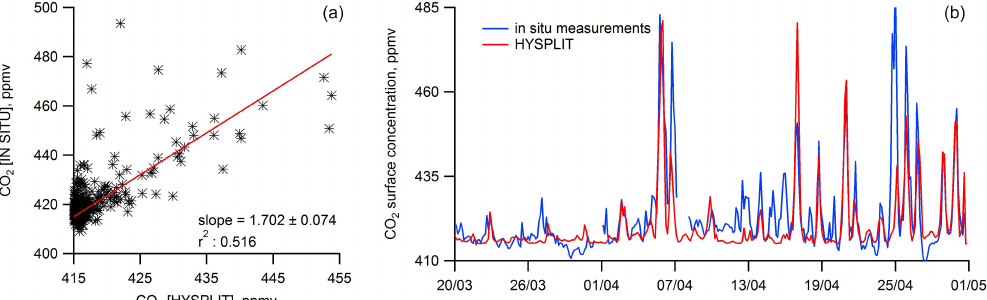
Figure 4. Comparison of the HYSPLIT simulations and the in situ measurements of surface CO 2 concentration in Peterhof (59.88 ◦ N, 29.82 ◦ E) in March–April 2019. (a) The values of surface CO 2 compared with the results of HYSPLIT simulations without the scaling of the ODIAC emissions data. (b) HYSPLIT data obtained using scaled ODIAC CO 2 emissions compared with observed surface CO 2 . Measurement and simulation data are averaged over 3h